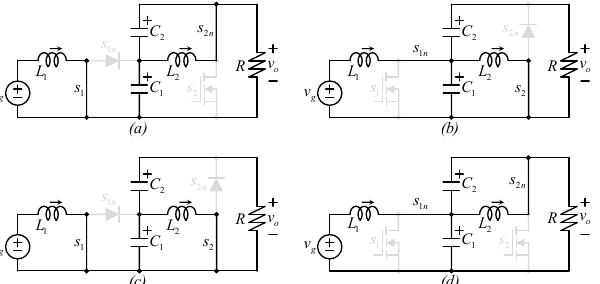
Figure 5. Equivalent circuit according to the switching state ( a ) s 1 = 1 and s 2 = 0 , ( b ) s 1 = 0 and s 2 = 1 , and ( c ) s 1 = 1 and s 2 = 1 , and ( d ) s 1 = 0 and s 2 = 0 . Even if the number of possible switching states is four, the number of switching states that appears during the operation mode is three (two in a particular point), and they depend on the value of the duty cycle D . The duty cycle D may change during the operation, adjusted by a controller (for example, a PID controller), to maintain the output voltage in a certain desired value. The operation of the converter can be classified in three possible cases (when D < 0.5 , D = 0.5 , and D > 0.66 ). Figure 6 shows three particular cases (when D = 0.33 , D = 0.5 , and D = 0.66 ) to exemplify how switching functions would look like and to observe how the different equivalent circuits may appear.